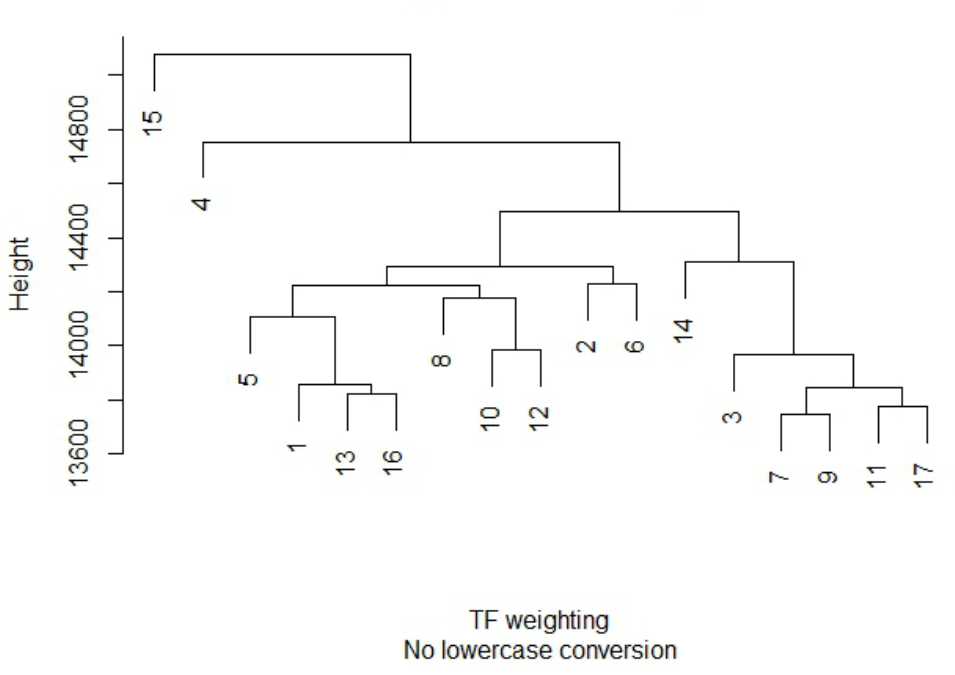
Figure 3: Hierarchical clustering of chapters using the UPGMA method with the Canberra distance. The six V. chapters stand grouped together in the rightmost branch of the dendrogram (14, 3, 7, 9, 11, 17). Changing the weighting to TF-IDF or converting to lowercase gives practically identical